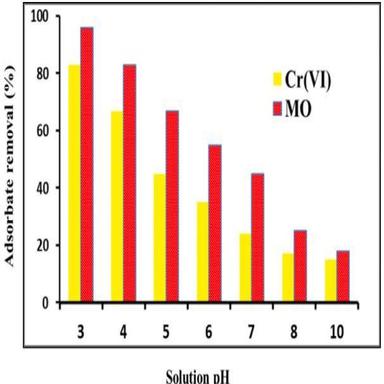
Effect of solution pH on the removal of Cr(VI) and MO by Mus/St/ MNPs adsorbent.